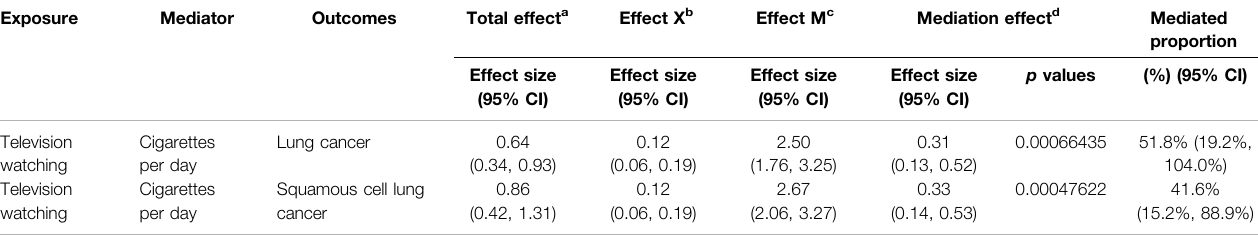
TABLE 4 | Mediation effect of television watching on lung cancer and squamous cell lung cancer via smoking quantity.